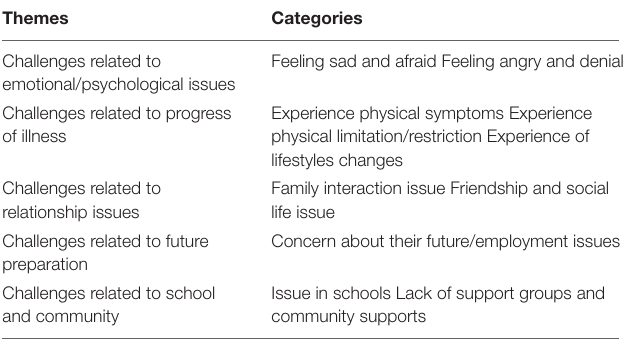
TABLE 2 | Findings on the experiences and challenges of adolescents with